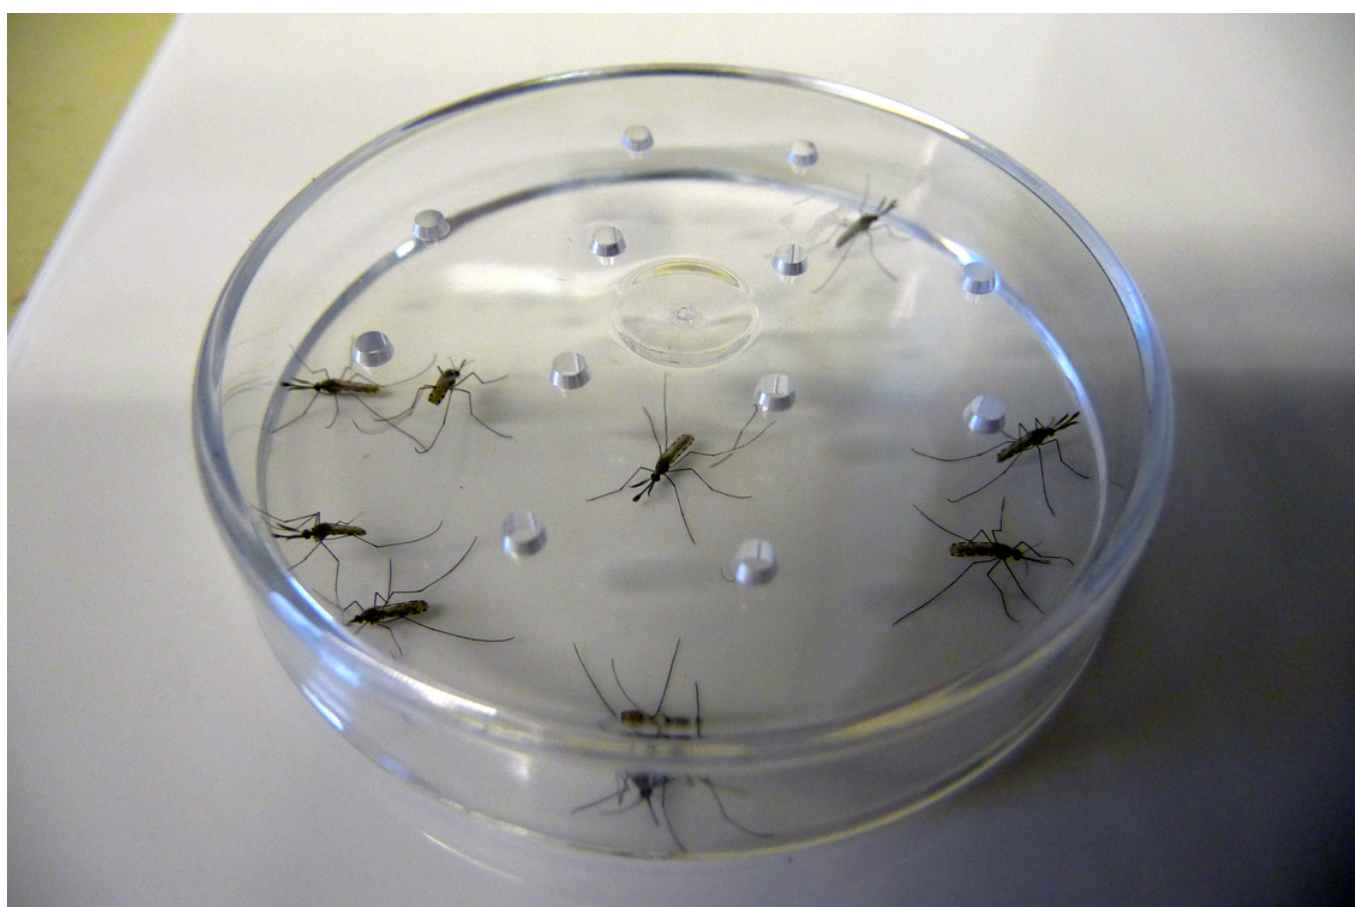
Fig 2. The close-up view reveals the contact of the test insect with the treated surface of the